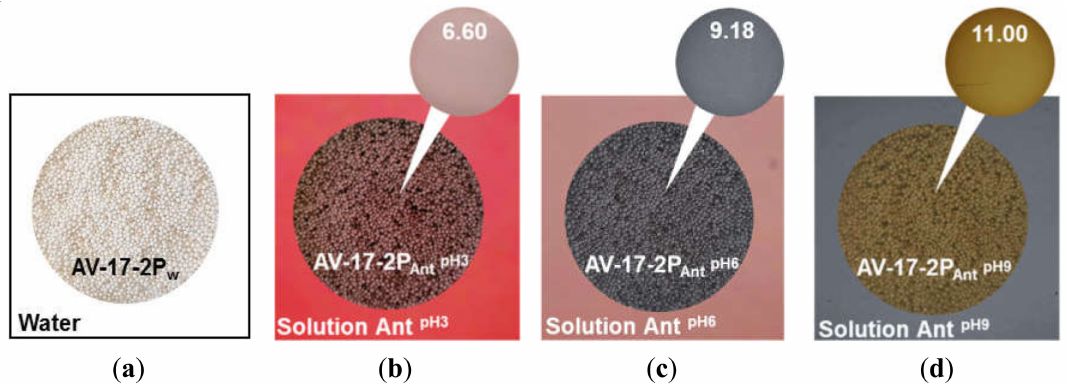
Figure 7. Color of the anion-exchange resin AV-17-2 in the Cl − form, equilibrated with deionized water ( a ) and anthocyanin solutions at pH 3 ( b ), 6 ( c ), and 9 ( d ). The upper circles represent the closest anthocyanin color on the colorimetric scale in solution (Figure 4); the number inside the circle indicates the pH value corresponding to that color.